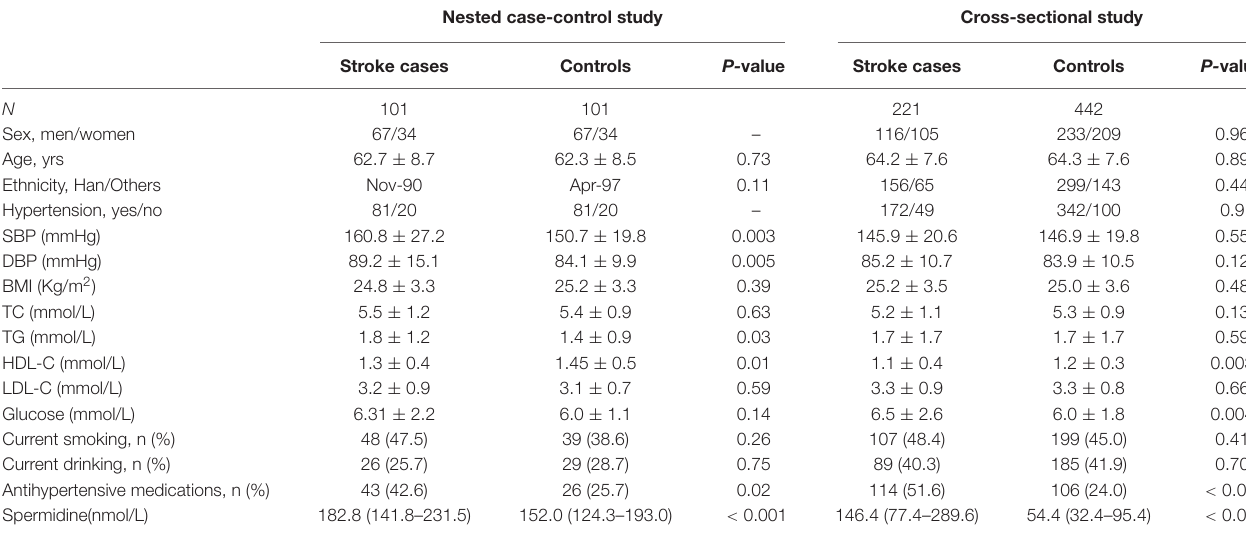
TABLE 1 | Characteristics of stroke patients and controls in prospective and retrospective case-control study. Nested case-control study